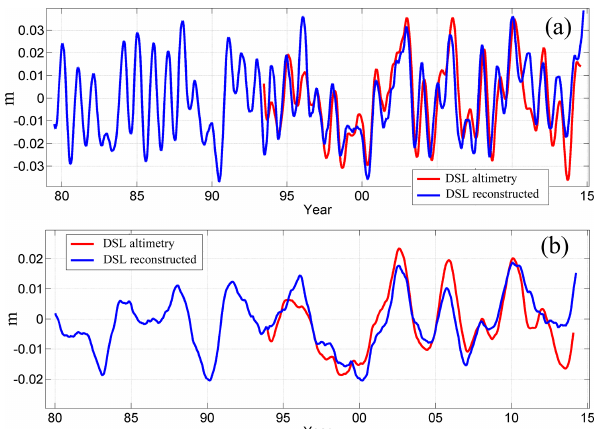
Figure 10. The time series of the altimetry-derived DSL (red curve) and DSL at 33.2 ◦ E, 44.7 ◦ N, reconstructed from the wind curl (blue curve): the time series are smoothed (a) with a 90-day moving av- erage and (b) with a 365-day moving